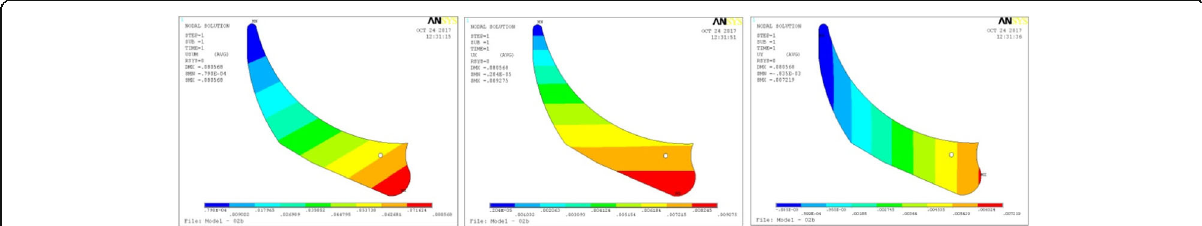
Fig. 2 Total deformation in the mandible and its components in horizontal and vertical directions